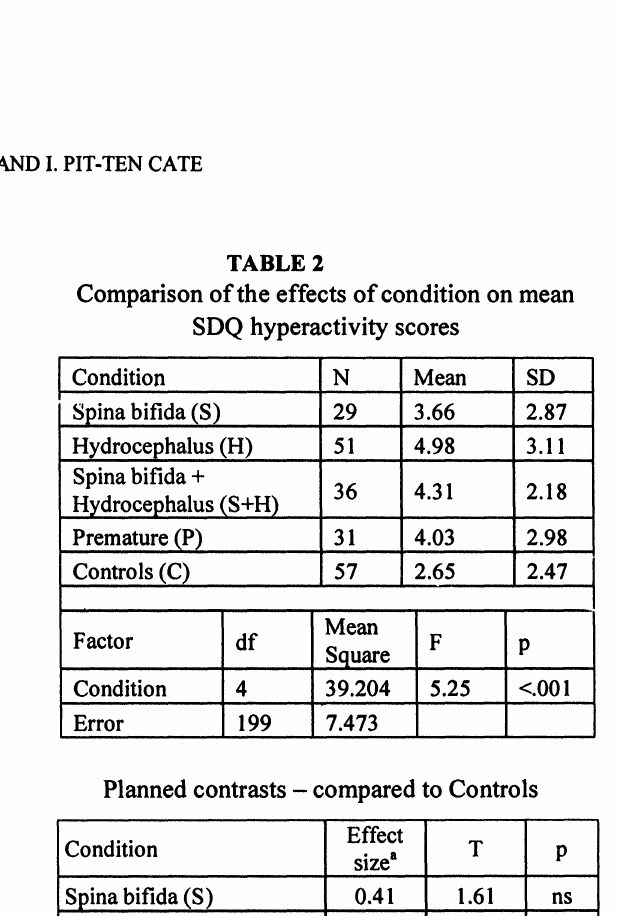
Comparison ofthe effects of hydrocephalus and prematurity on mean SDQ hyperactivity